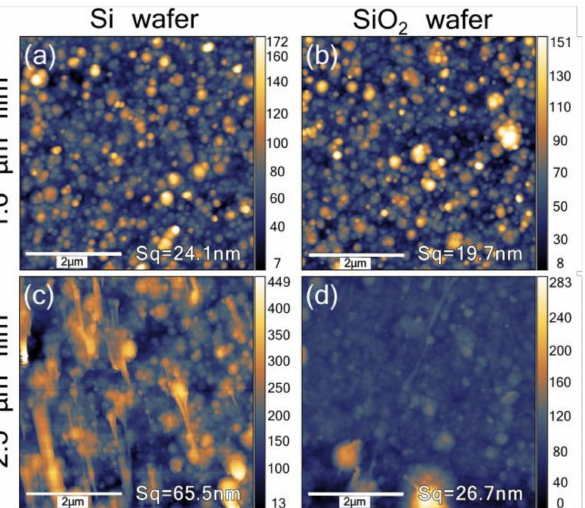
Figure 6. Surface morphology images of the 1.6 µ m AF4 coating on Si ( a ) and SiO 2 ( b ) substrates and 2.5 µ m AF4 films deposited on Si ( c ) and SiO 2 ( d ) substrates obtained via atomic force microscopy. The rms surface roughness, Sq, is given in the corresponding